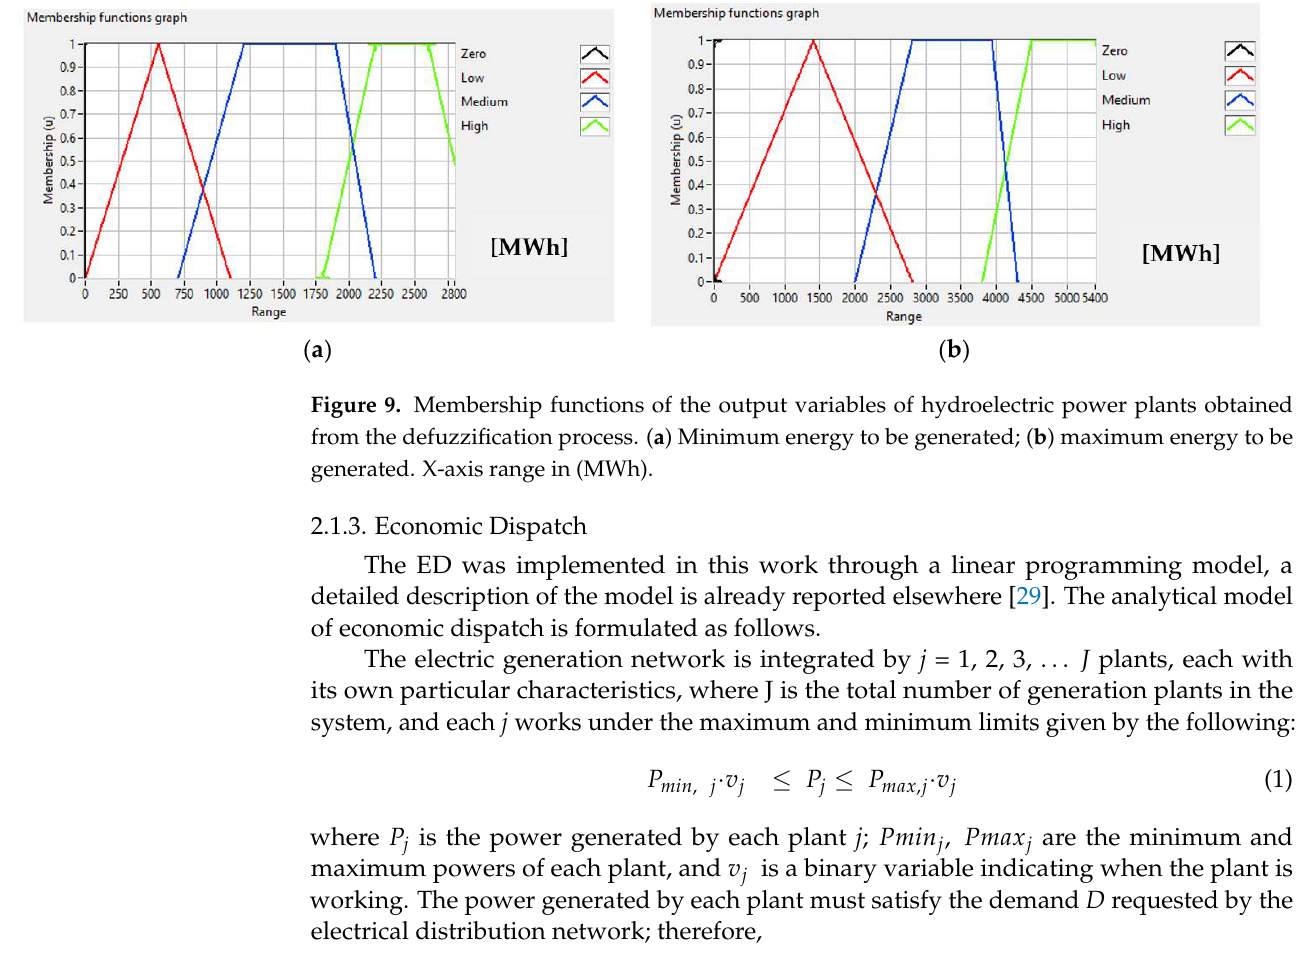
Figure 8. Inference rules of the hydropower fuzzy system.